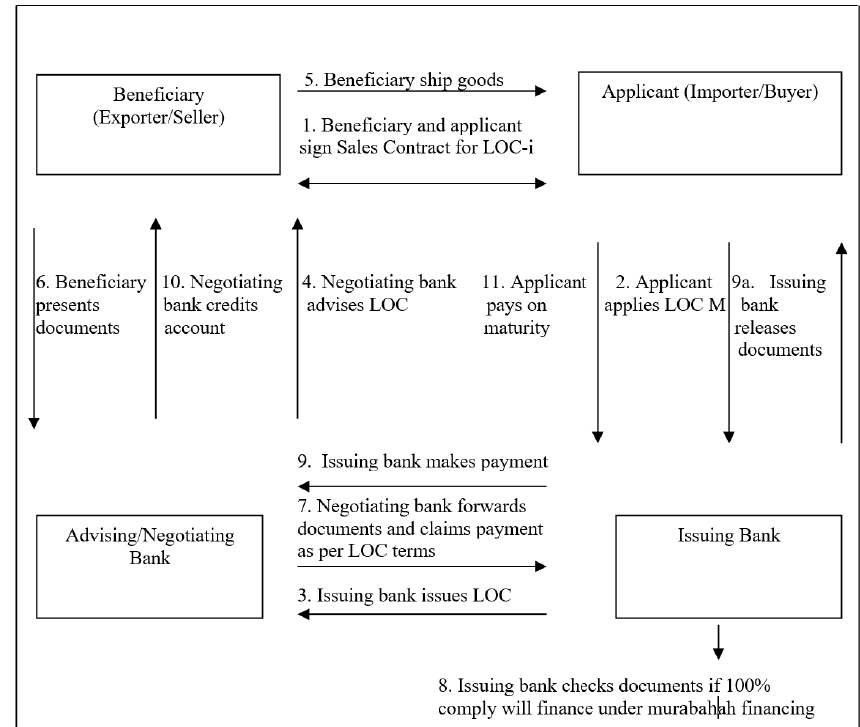
Figure 2. The process flow of the operation of LC Murabahah.